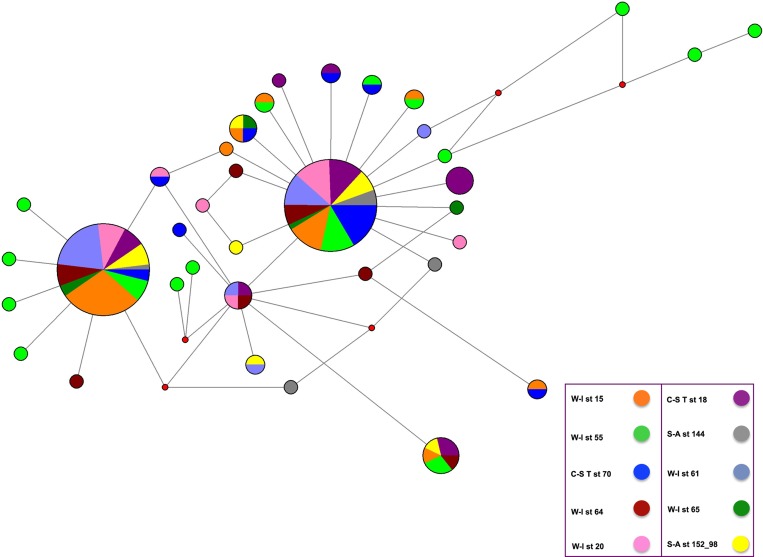
Median-joining network of haplotypes detected for the concatenated 16S rDNA and COI sequences.The area of each circle is proportional to the number of individuals exhibiting that haplotype. Branch length is proportional to the number of mutations occurred. Red dots represent missing or undetected haplotypes. The most frequent haplotypes are shared by individuals from all localities.